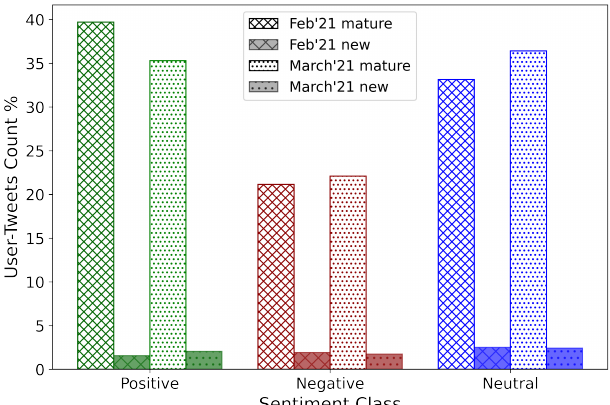
Figure 7. Temporal sentiment analysis in early February and late March 2021 by the type of Twitter account users (new users vs. mature users).